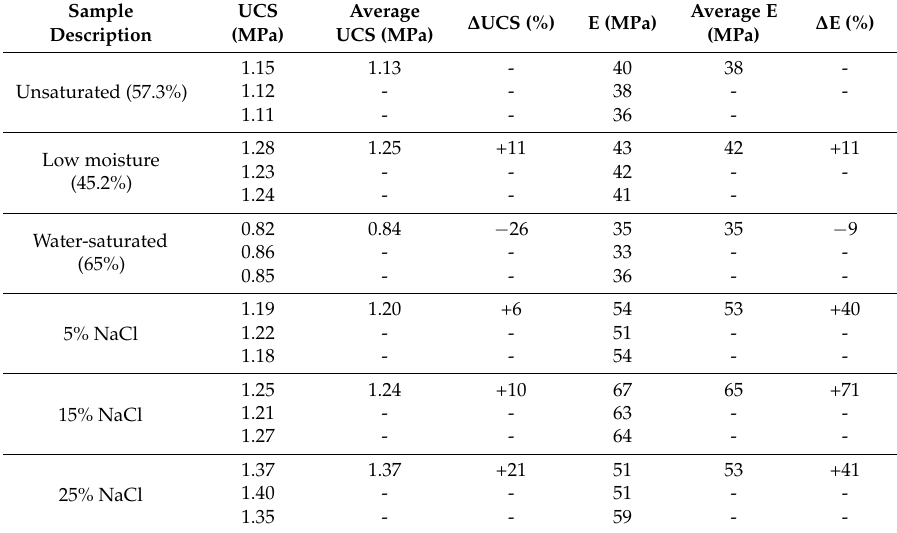
Table 5. Uniaxial compressive strength (UCS) and Young’s modulus (E) of all samples and comparison of these values with values of unsaturated